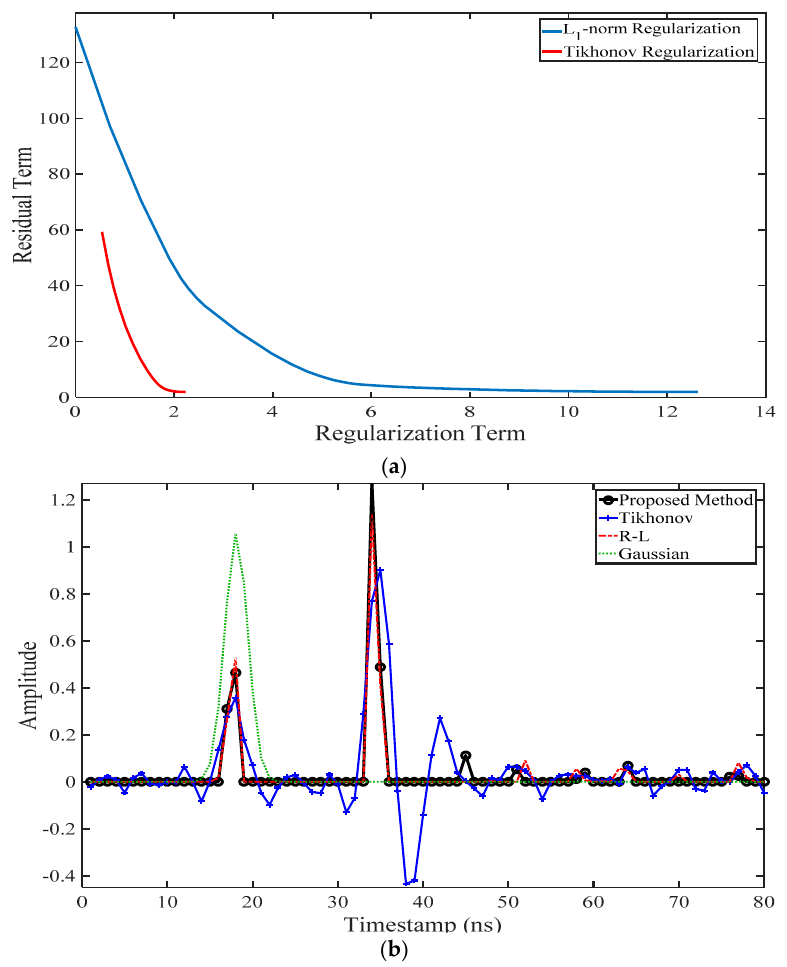
Figure 10. ( a ) The L-curve results corresponding to the l 1 -norm regularization and Tikhonov regularization methods; and ( b ) restored signals from different methods. regularization methods; and ( b ) restored signals from different